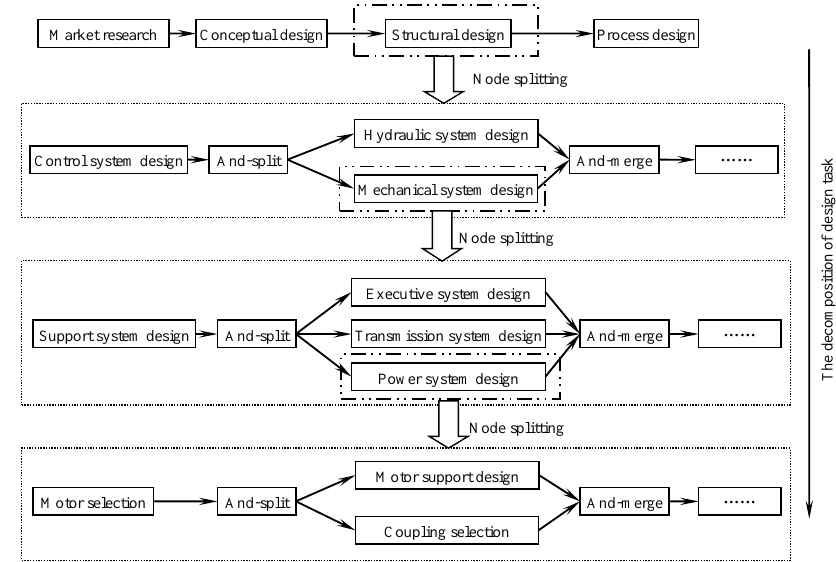
Figure 5. The decomposition process of product design process.